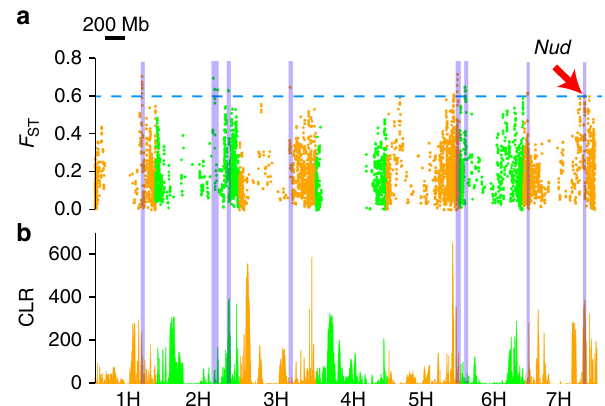
Fig. 5 Candidate genomic selective of qingke. a Hudson ’ s F ST for 10 kb windows compared between qingke and eastern groups. Regions of F ST ≥ 0.6 above the blue dash line were considered as the candidate selective regions. The Nud locus for naked caryopsis was 14 Mb away from a candidate window located at 560.94 Mb in 7H. b The selective sweep signal of the qingke group. Large values of the maximum composite likelihood ratio (CLR) correspond to strong sweeps. Candidate selective regions revealed by F ST are highlighted in blue in both ( a , b ). Source